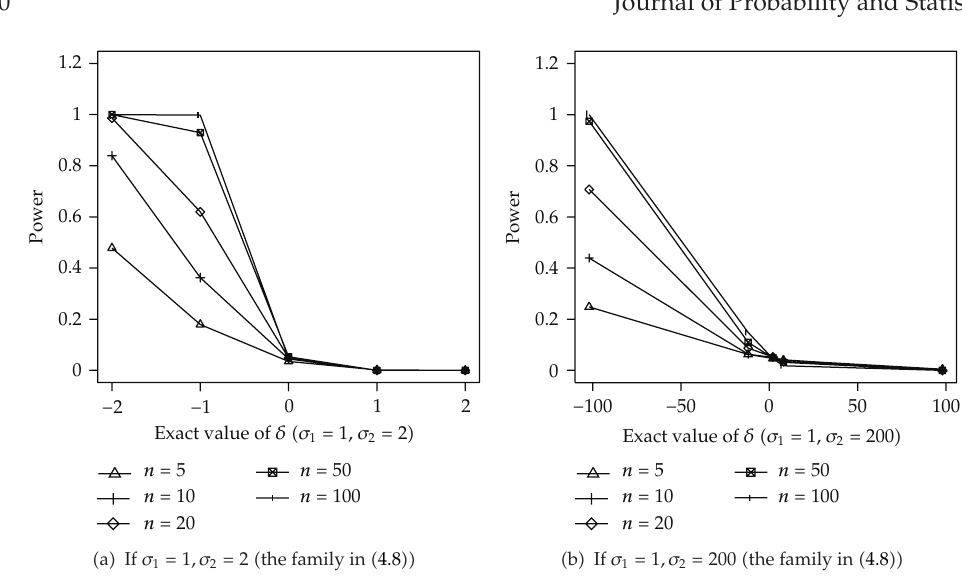
Figure 1: The simulated power versus δ (cid:2) the family case in (cid:2) 4.8 (cid:3)(cid:3) .